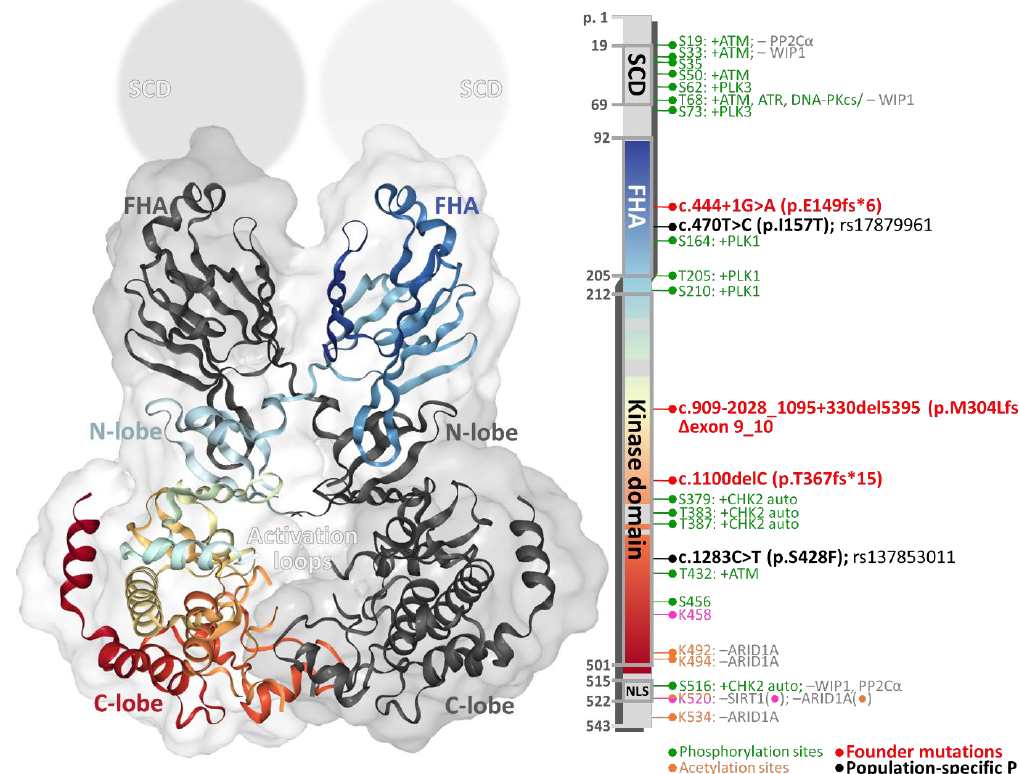
Figure 1. The structure of a CHK2 dimer (left; www.rscb.org/structure/3I6W) consists of intertwined monomers (one subunit is colored in gray, and the second subunit is colored in gradient from the N- to C-terminus; missing parts of 3D structures are colored in gray). The same color-coding of the bar (right) indicates the positions of conserved domains (boundaries reflect the crystallographic analysis by Cai et al. [35]). Lollipops depict known sites of covalent modifications, founder mutations, and variants.